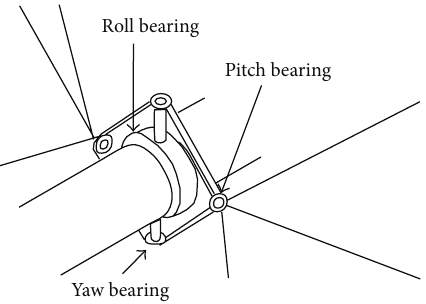
Figure 13: Proposed six-wire system configuration [92].